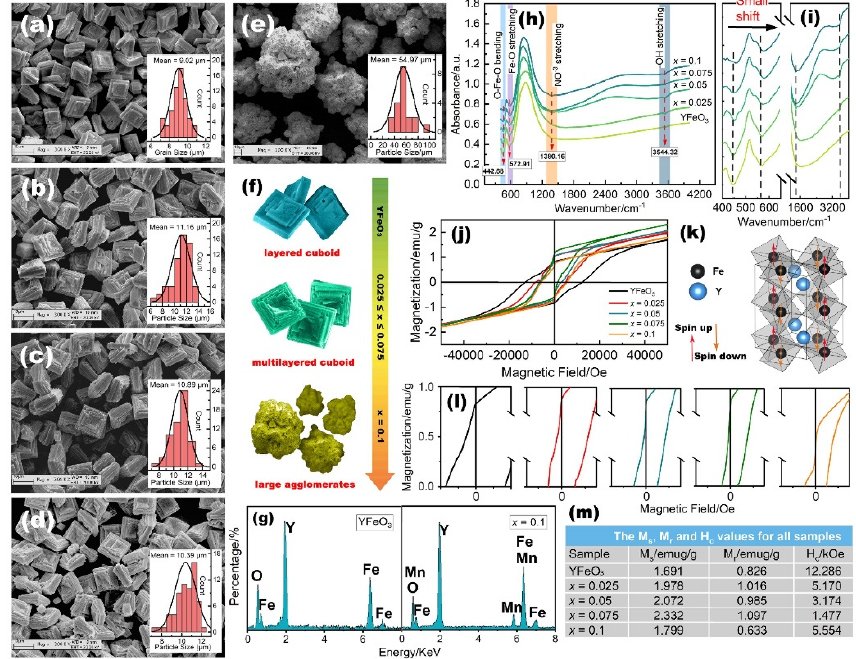
Figure 2. ( a – e ) SEM micrographs of YFM x O (0 ≤ x ≤ 0.1), the histograms in the insets are the grain size distributions; ( f ) schematic illustration of shape evolution; ( g ) EDS spectra of YFM x O ( x = 0, 0.1); ( h ) FT-IR spectra of YFM x O; ( i ) selected part of the IR spectrum; ( j ) M-H loops of YFM x O; ( k ) magnetic moment in YFO structure; ( l ) zoomed-in view of M-H curves; ( m ) the M s , M r , and H c values of YFM x O.